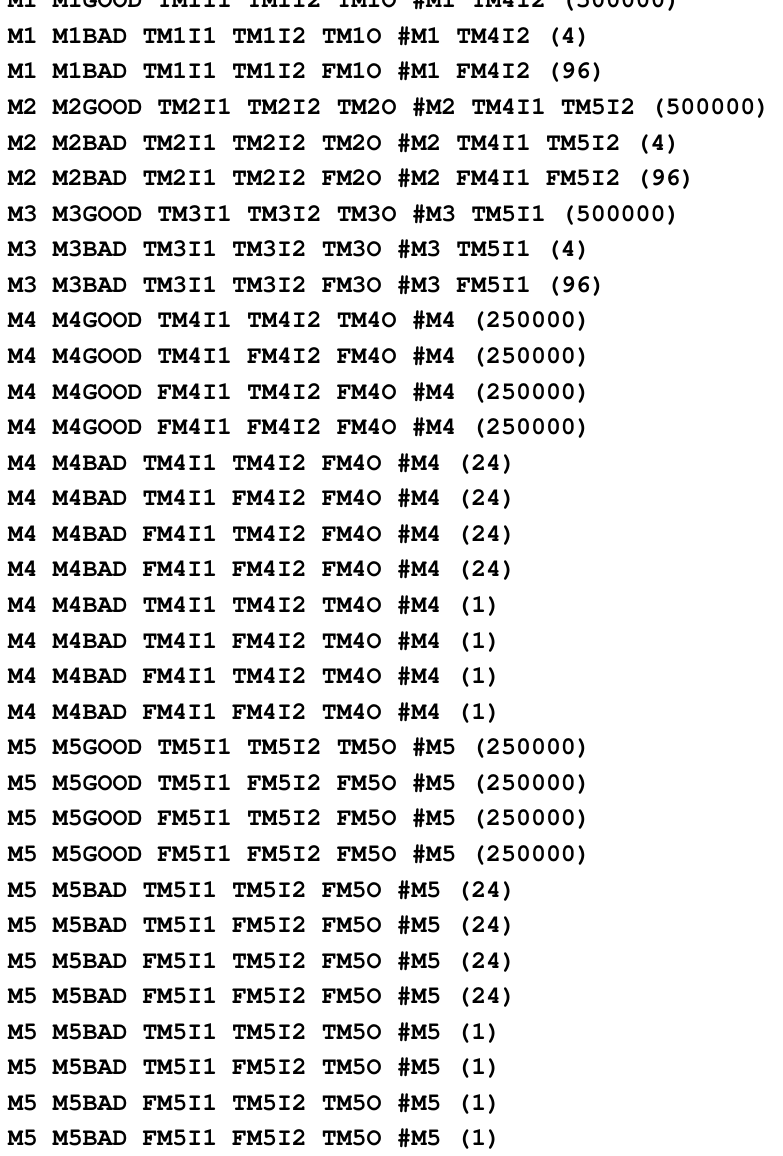
Figure 27. A set of SP patterns modelling input-output relations in the electronic circuit shown in Figure 25. They were supplied as Old patterns to the SP model for the building of the multiple alignment shown in Figure 28. Key : “ T ” = true (information is correct); “ F ” = false (information is incorrect); “ M1 ”, “ M2 ”, “ M3 ”, “ M4 ”, “ M5 ” = components of the circuit; “ GOOD ”, “ BAD ” indicates whether a component is good or bad; “ I1 ”, “ I2 ” =